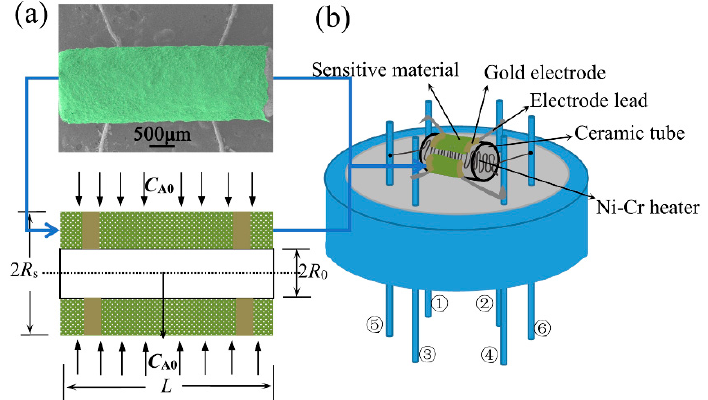
Figure 1. Physical model and schematic diagram of gas sensor. ① , ② , ③ , ④ measuring electrodes; ⑤ and ⑥ heating electrodes. ( a ) SEM image and physical model of gas sensor; ( b ) Schematic diagram of sensor structure.